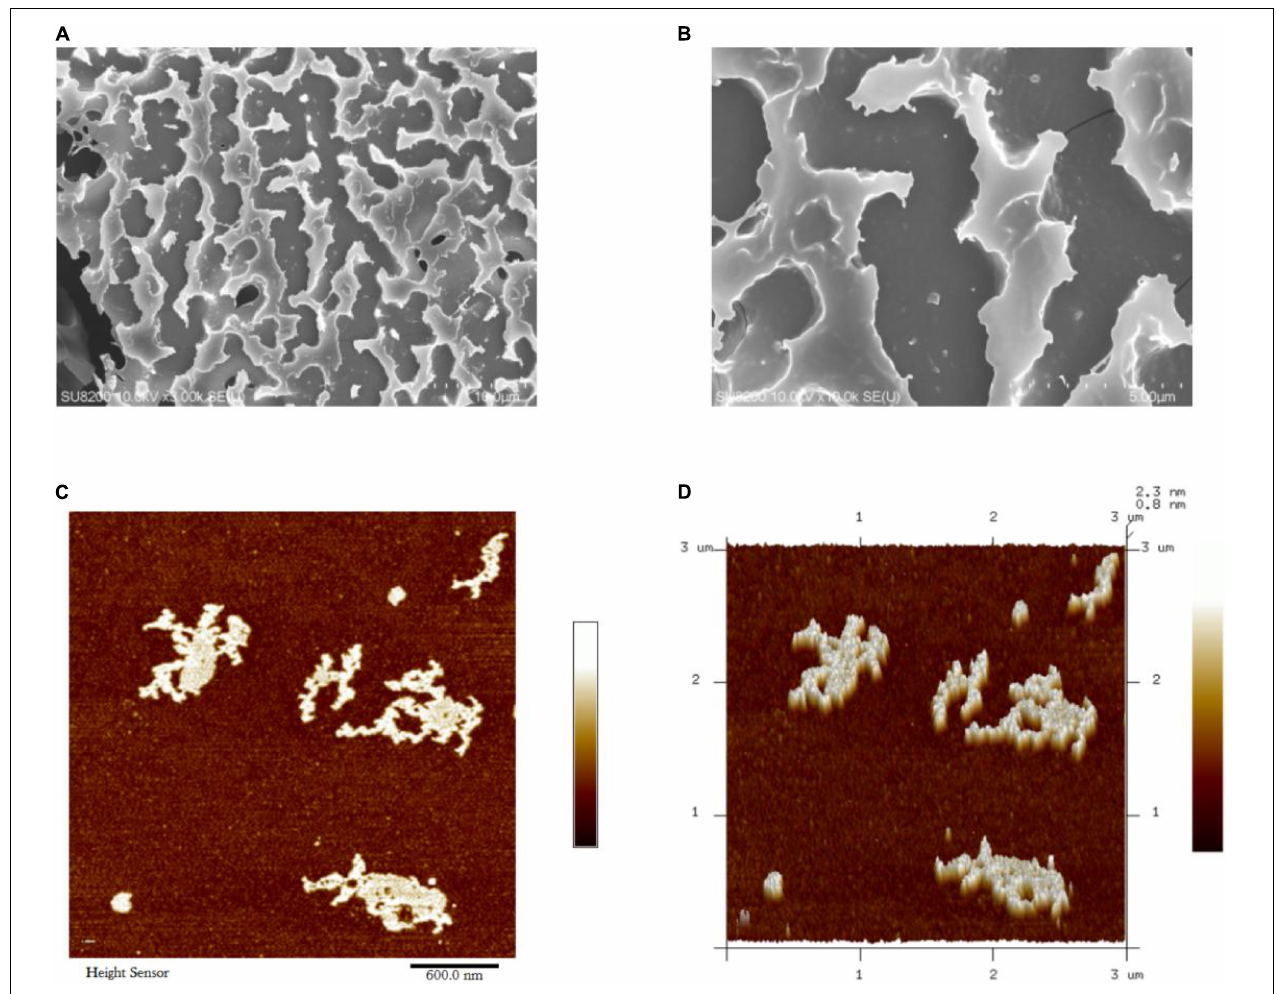
FIGURE 4 | SEM of JCH-a1 [ (A) 10 µ m; (B) 5 µ m]; AFM images of JCH-a1 (C,D)